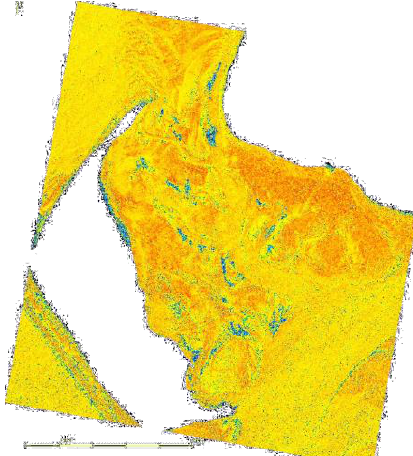
Figure 7. Result of the spatial computation of the new indicator for bivalve beds, derived as the absolute value of the local mean and standard deviation of the polarization coefficient (Eq. 1). Blue patches on the open flats correspond to areas with values below 0.02 and coincide with detected oyster